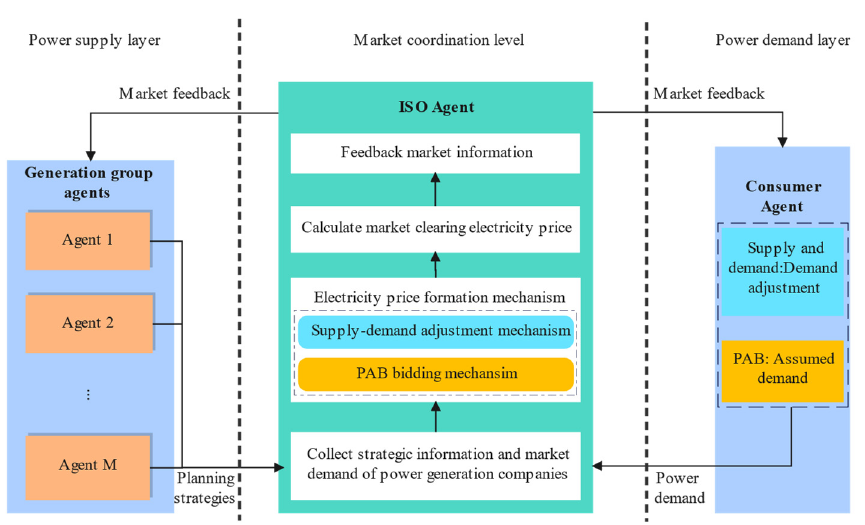
Figure 3. Generation-side market multi-agent model framework.